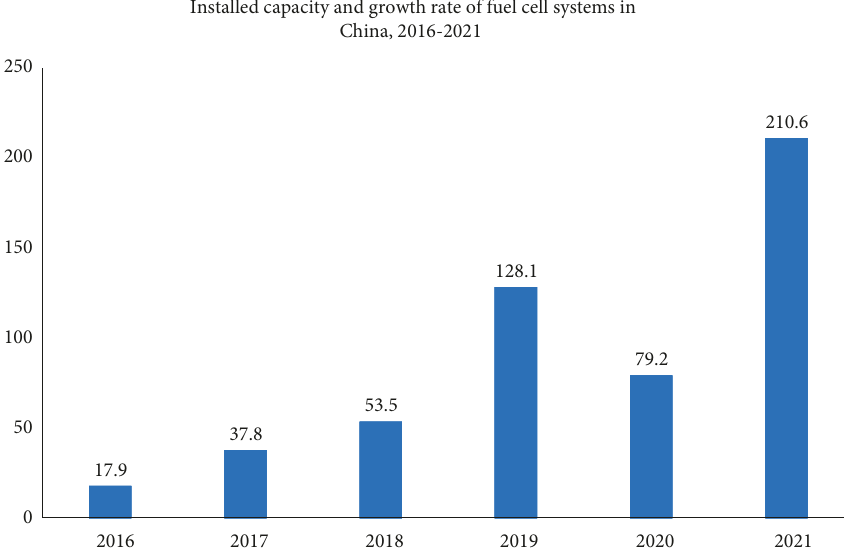
Figure 6: Installed capacity and growth rate of fuel cell systems in China,